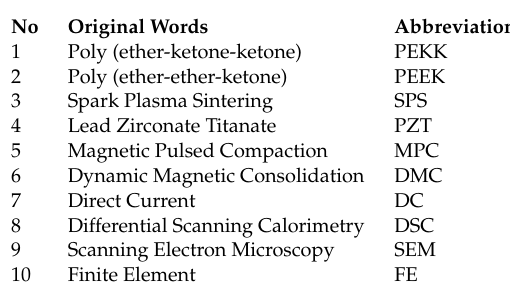
Figure S2: Discharge current-Capacitance during the different discharge voltage. (a) Relationship between capacitance and current; (b) Relationship between capacitance and magnetic, Figure S3: Relationship between energy and discharge current and voltage. Figure S4: The different capacitance influence on discharge current, Figure S5: The different capacitance influence on electromagnetic force, Figure S6: Influence of different energy on compaction